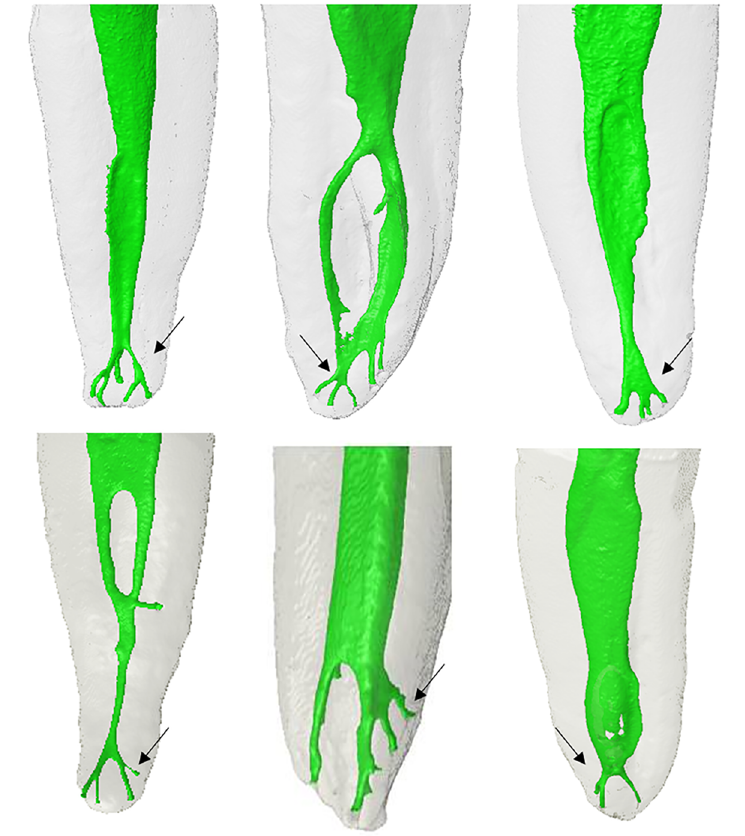
Figure 3- 3D models of human teeth showing the variability of the root canal system morphology. The black arrows indicate the variability of apical deltas